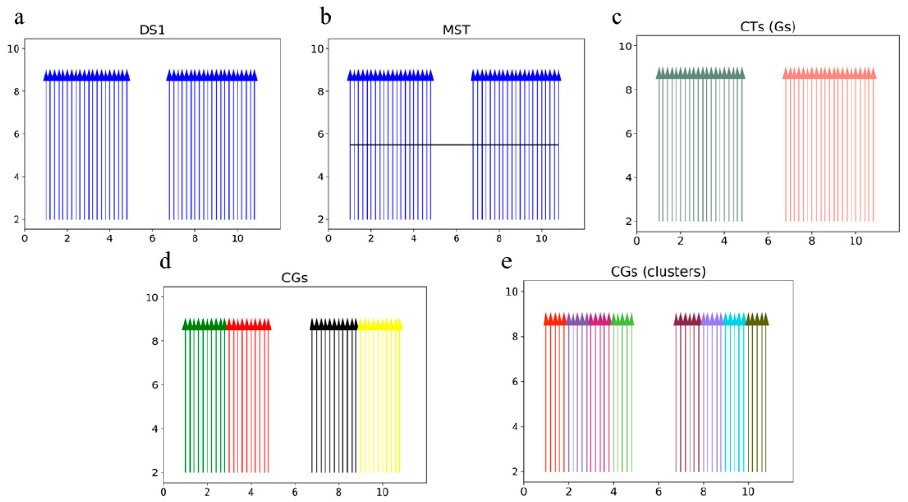
Figure 5. Illustration of the clustering process. ( a ) DS1; ( b ) MST (maximum spanning tree); ( c ) CTs (child trees); ( d ) CGs (child graphs) obtained by partitioning the Gs ; ( e ) CGs obtained by partitioning the CGs .